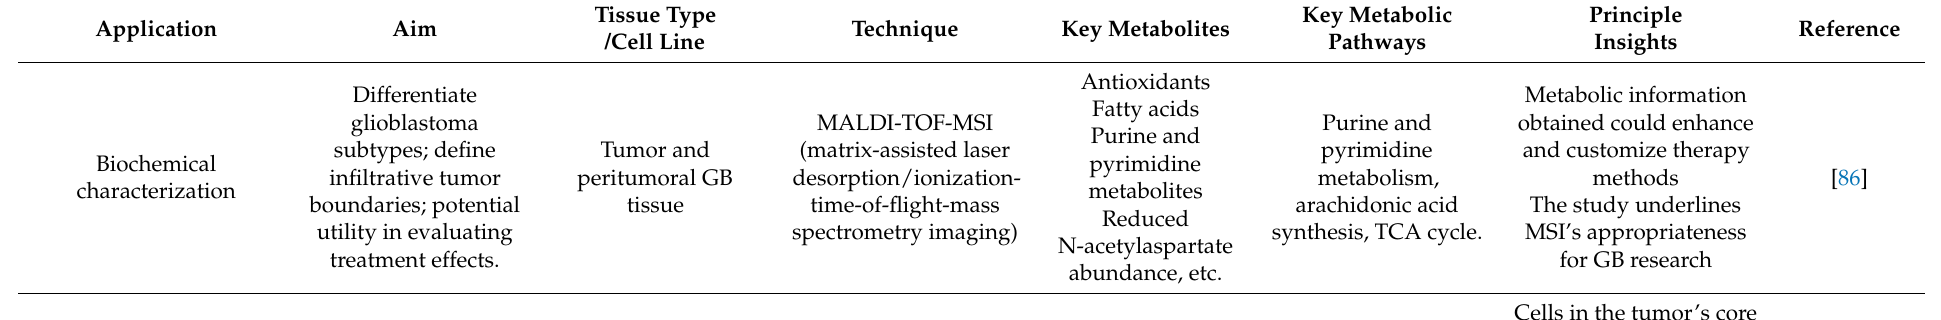
Table 2. Summary of studies employing metabolomics in GB